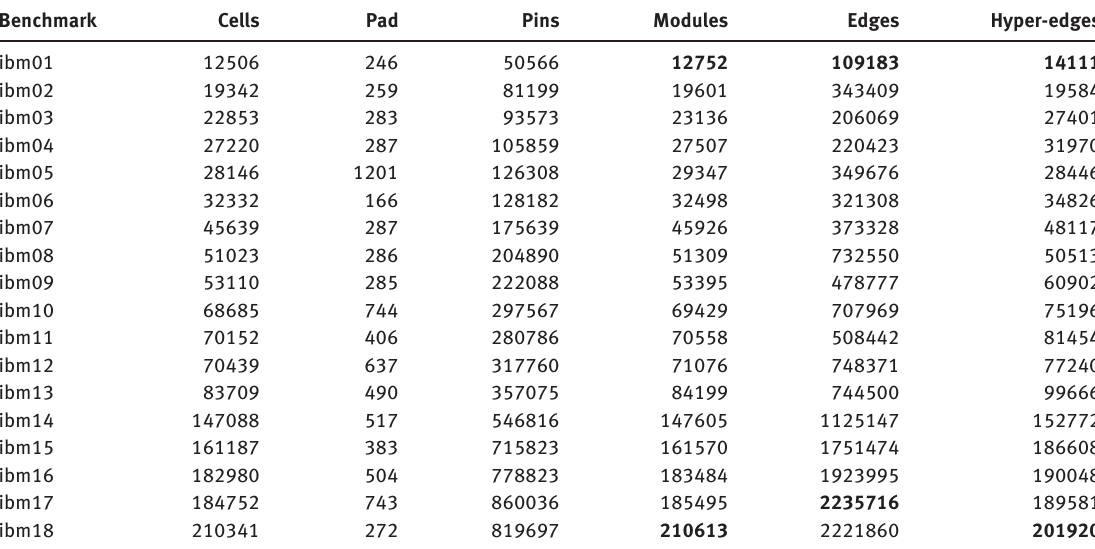
Table 1: The Characteristics of 18 Weighted Graphs and Weighted Hyper-Graphs of ISPD98 Benchmark. Benchmark